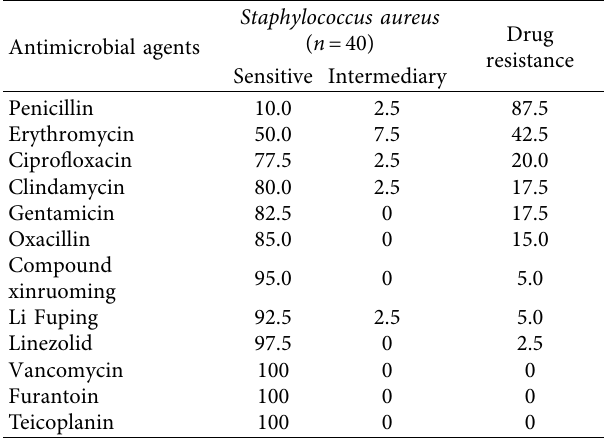
Table 6: Resistance rate of Gram-positive other staphylococci (%). Antimicrobial